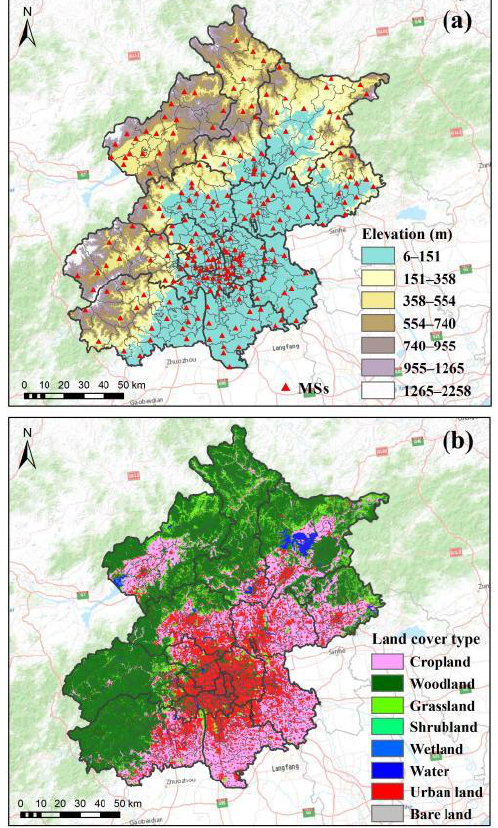
Figure 1. ( a ) Elevations and locations of meteorological stations (MSs). ( b ) Land cover types of cropland, woodland, grassland, shrubland, wetland, water, urban land, and bare land in 2020. (The black border represents the administrative border of the district; the gray border represents the administrative border of the township. Data on administrative boundaries were obtained from the National Geomatics Center of China.).